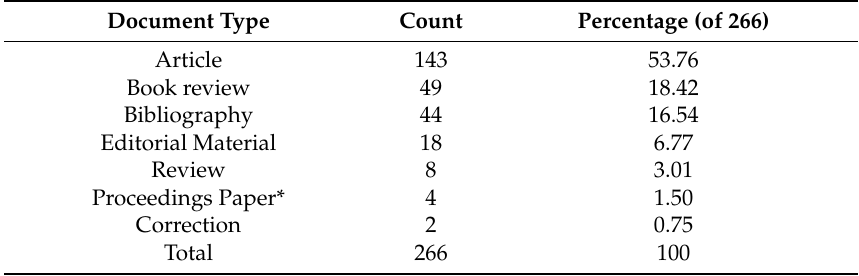
Table 6. Document types for SLW publications (Proceedings papers* considered as articles).